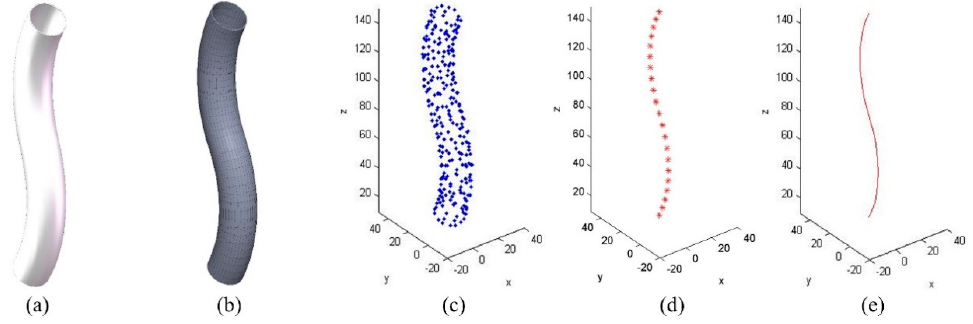
Figure 7. Skeleton curve extraction process: ( a ) Designed model, ( b ) Stereolithography (STL) file, ( c ) Point cloud, ( d ) Skeleton point, ( e ) Skeleton curve.